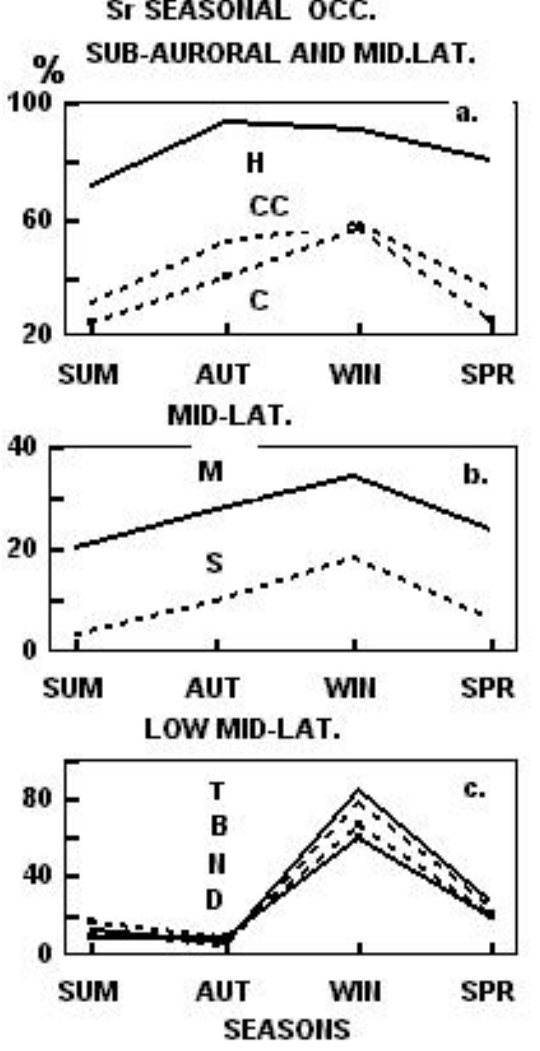
Fig. 4. Seasonal percentage occurrences of range spread-F at the different ionospheric regions and for different stations.